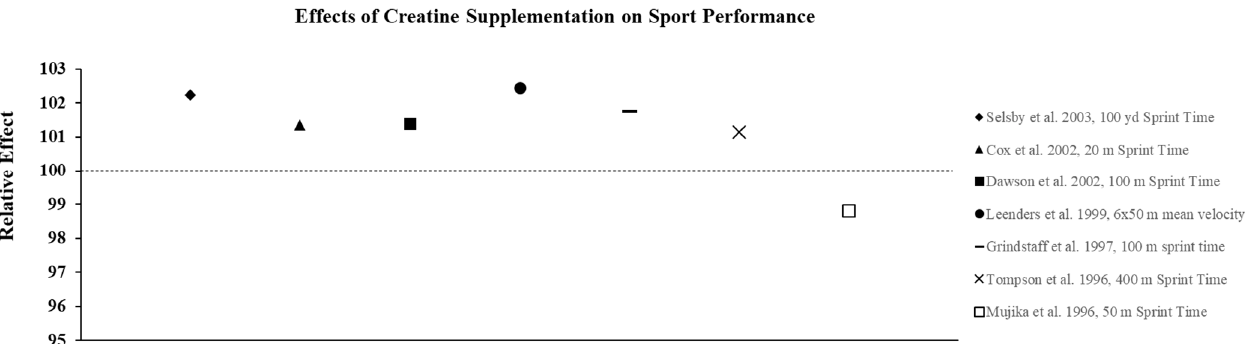
Figure 3. The relative effects of creatine supplementation in comparison to a placebo on exercise performance in females.